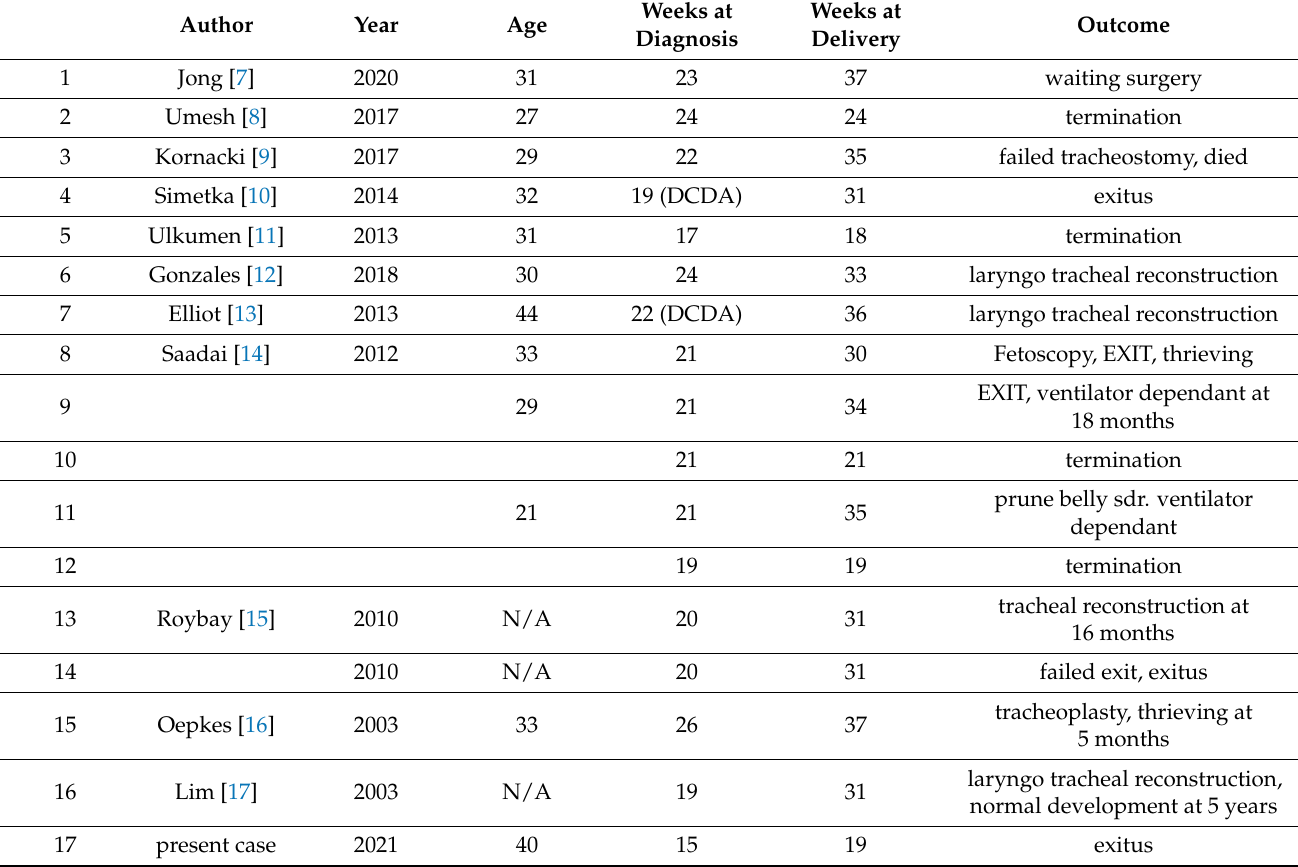
Table 1. Tracheal agenesis/atresia with known